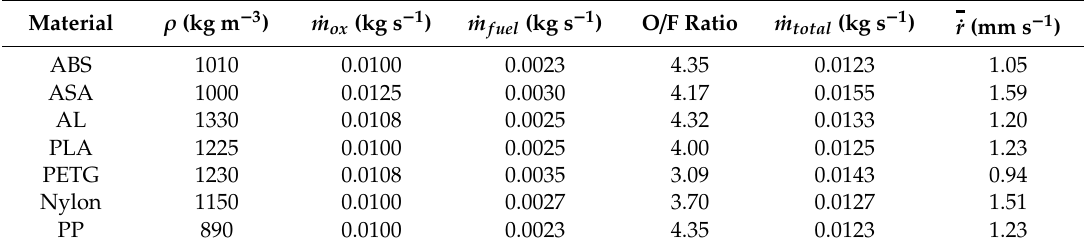
Table 2. Results of the small-scale test fire of 3D-printed fuel